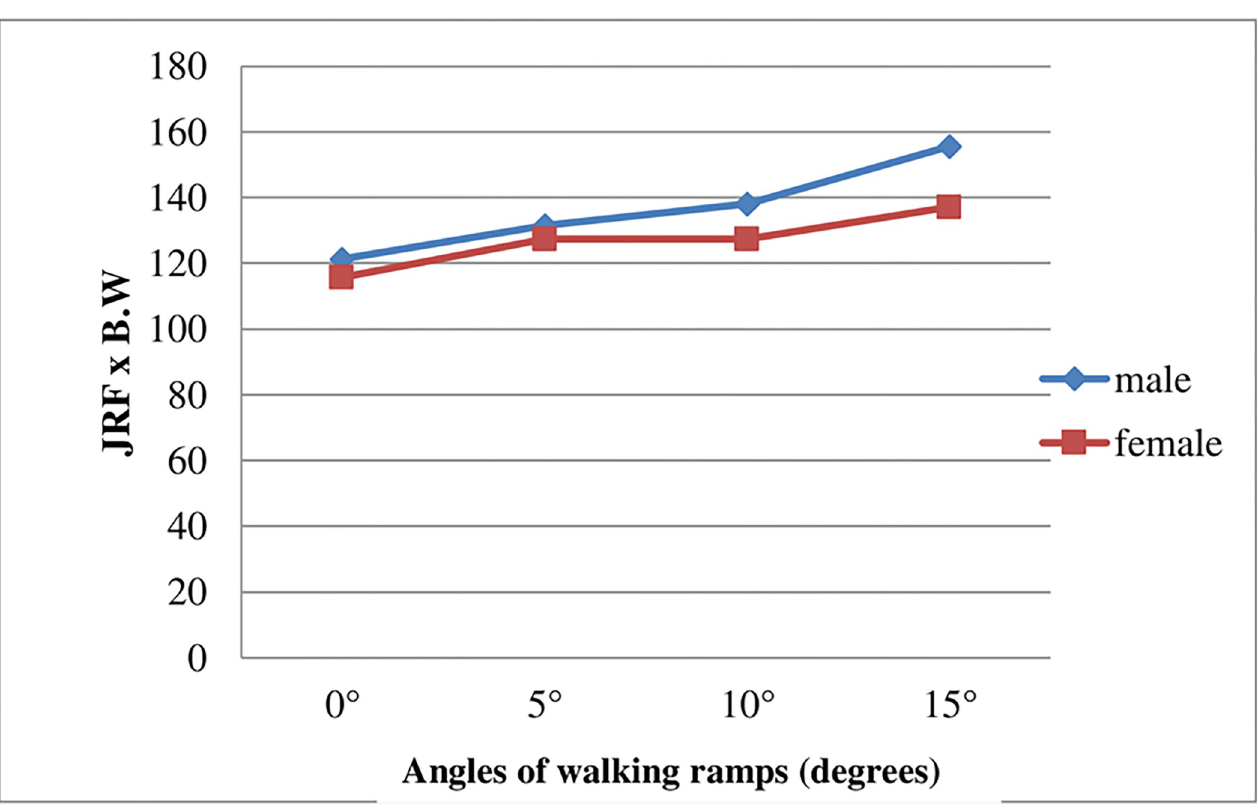
Fig 3. The interaction in the mean difference of the right hip joint reaction force between males and females among the four walking ramps during single-limb